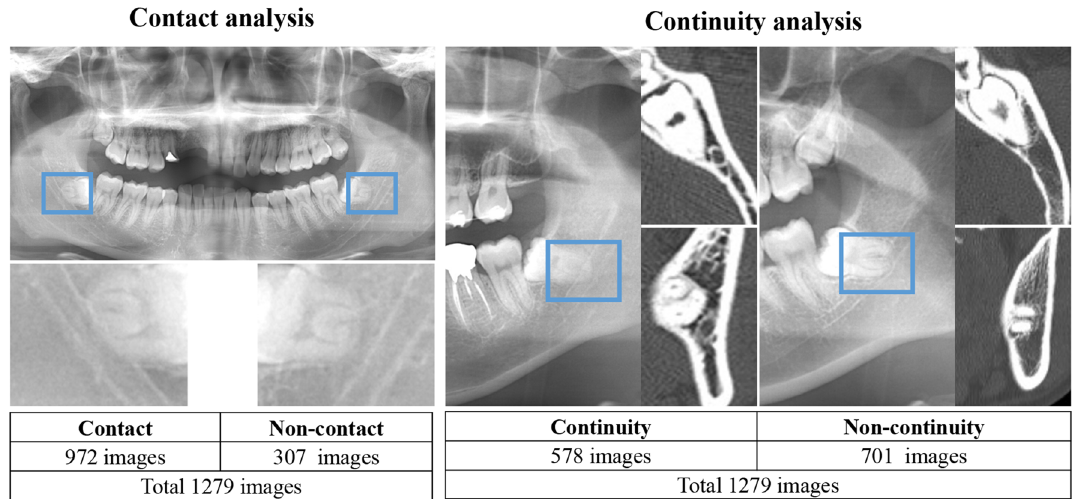
Figure 1. Classification of the relationship between the mandibular third molar and inferior alveolar canal/ nerve.